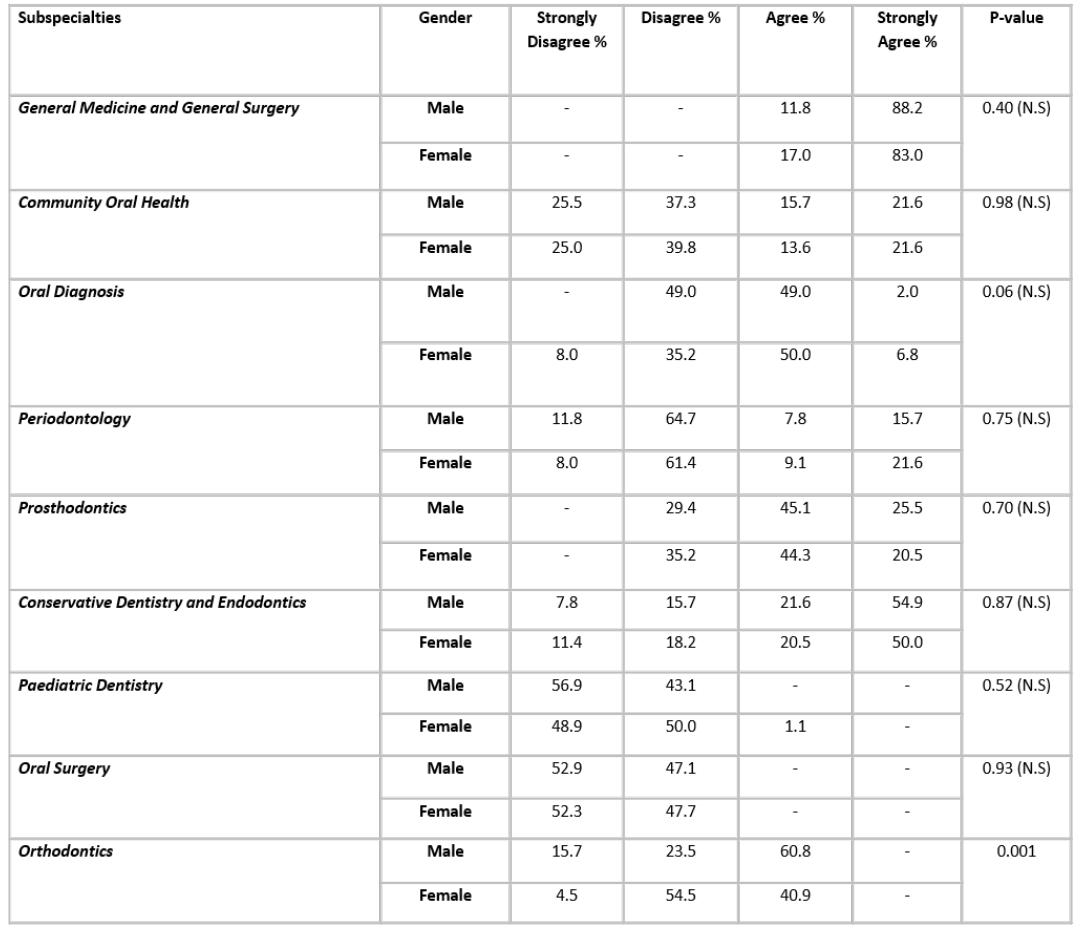
Table 6: Subspecialties most negatively affected by quarantine based on gender